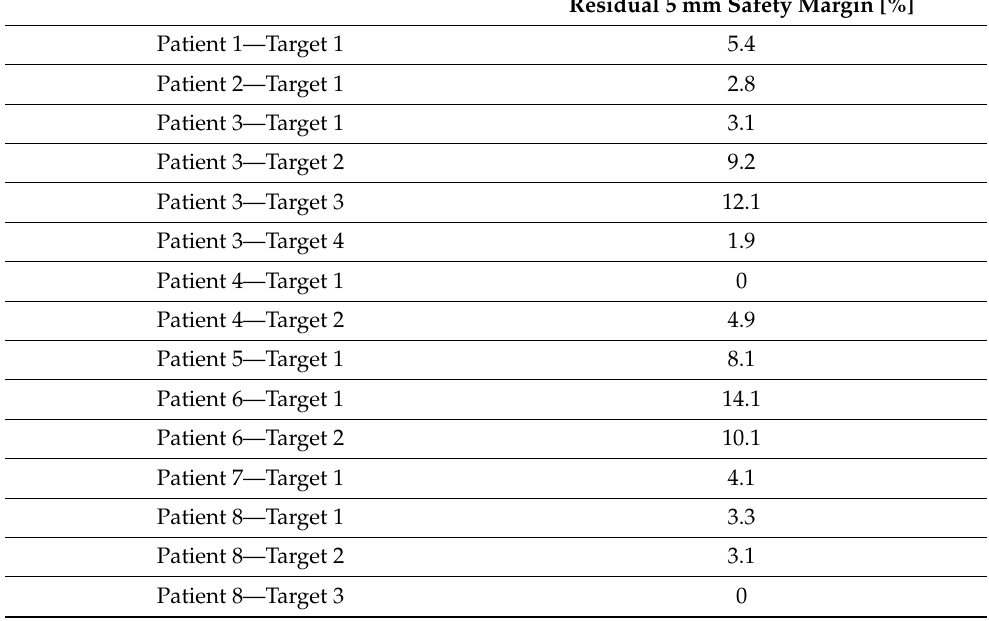
Table 2. Residual 5-mm safety margin (as a percentage) of each target tumor, calculated by the Ablation-fit TM